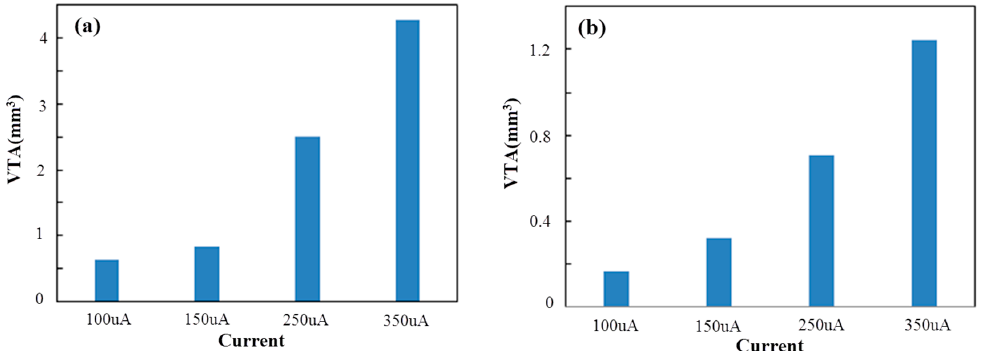
Figure 10. Effects of the stimulus intensity on the VTA during ( a ) double-side monopole stimulation; ( b ) single-side monopole stimulation.